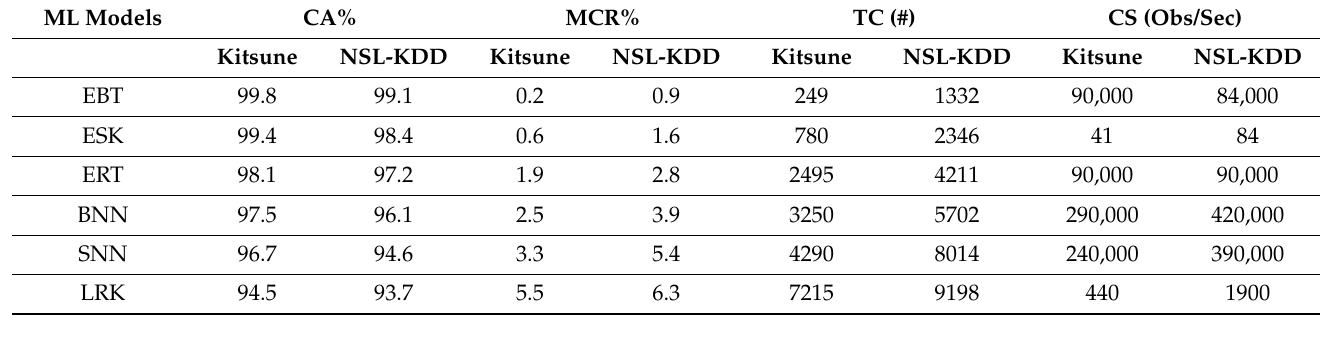
Table 6. Summary of system evaluation results comparing performance of Kitsune and NSL- KDD datasets.